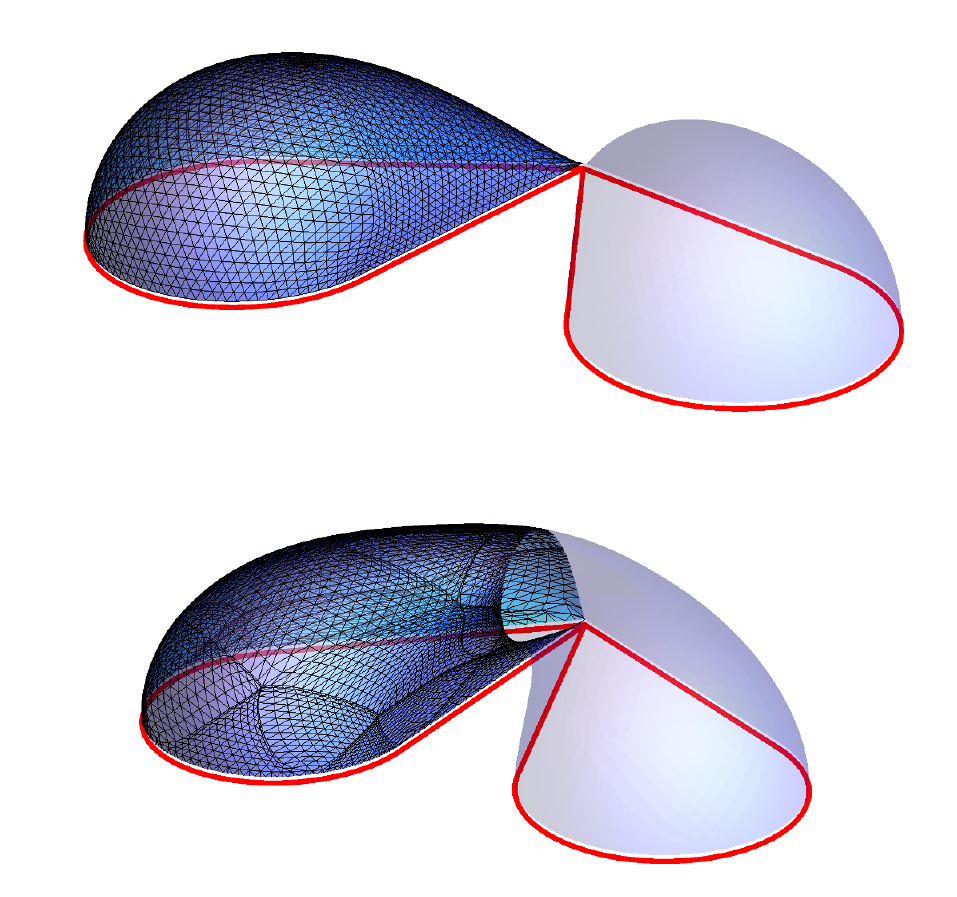
Figure 7 . Triangulated surfaces in H 3 which approximate the minimal area surfaces ^ (cid:13) A corre- sponding to two di(cid:11)erent double drop regions A which are symmetric w.r.t. a straight line passing through the vertex. For these domains (cid:30) 1 = (cid:30) 2 (cid:17) (cid:30) (see section 3.2). The boundary @A (red curve) belongs to the z = 0 plane and the UV cuto(cid:11) is " = 0 : 03. Top: L = 1 : 5 with (cid:30) = 0 : 9 and ’ 1 = 0 : 671. Bottom: L = 1 : 5 with (cid:30) = 0 : 8 and ’ 1 = 0 :